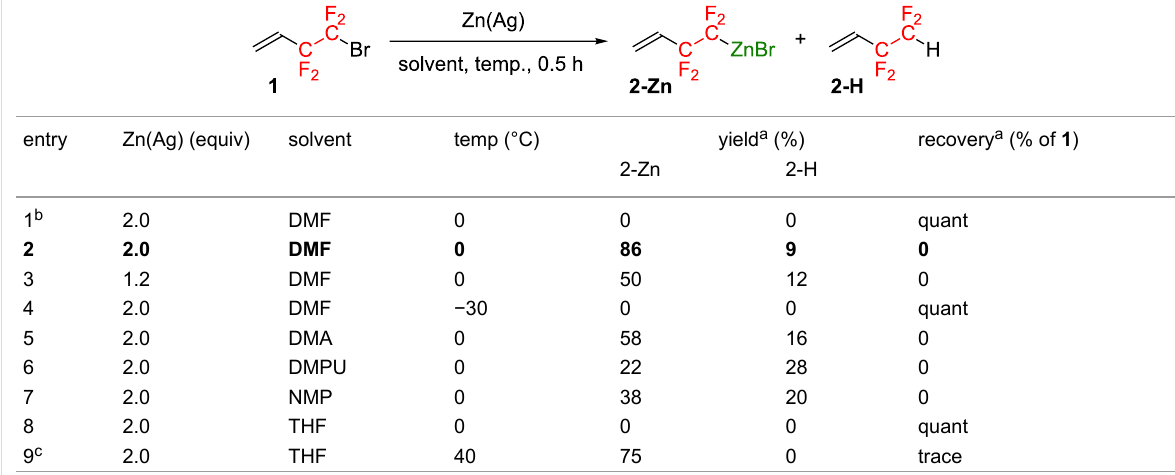
Table 1: Optimization of the reaction conditions for the preparation of 2-Zn .